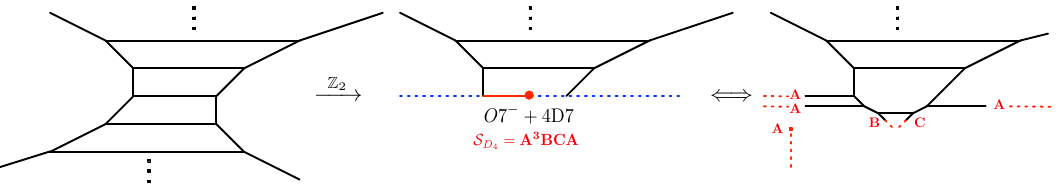
Figure 20 . The Z 2 quotient of SU(2 N + 1) 0 theory with no flavor. The resulting theory is Sp( N ) + 3 F , after the Hanany-Witten transition associated with a D7-brane (or A